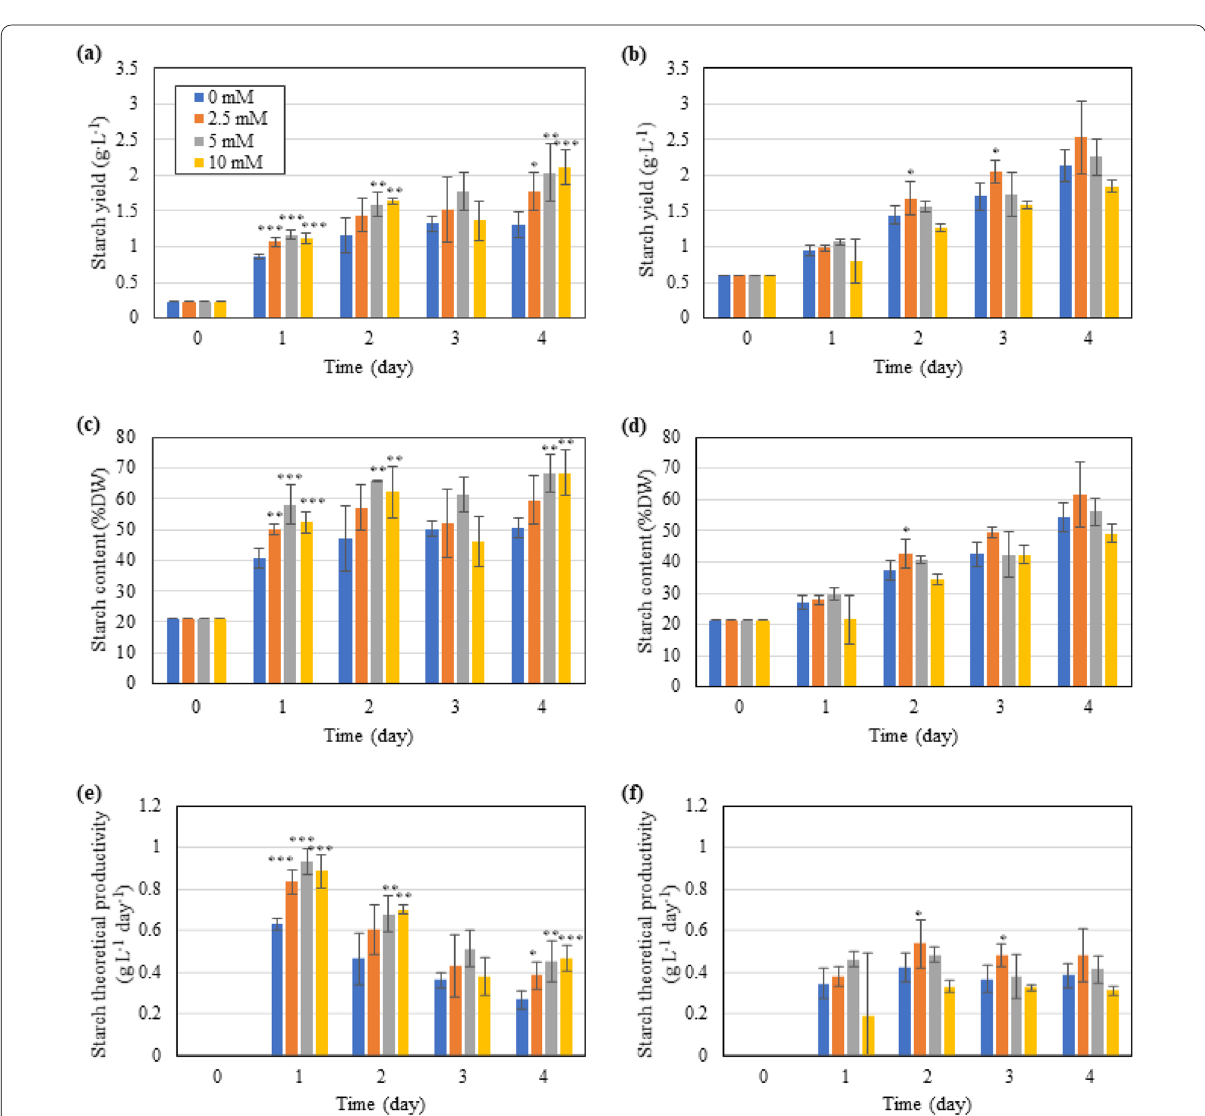
Fig. 5 Effect of exogenous GABA supply on the starch content ( a , b ), yield ( c , d ), and theoretical productivity ( e , f ) in T. subcordiformis exposed to nitrogen deprivation under NICD ( a , c and e ) and HICD ( b , d and f ). *, **, and *** denote the significant differences at p < 0.1, p < 0.05, and p < 0.01 levels, respectively, under different GABA conditions (2.5–10 mM) compared to those under 0 mM GABA (means